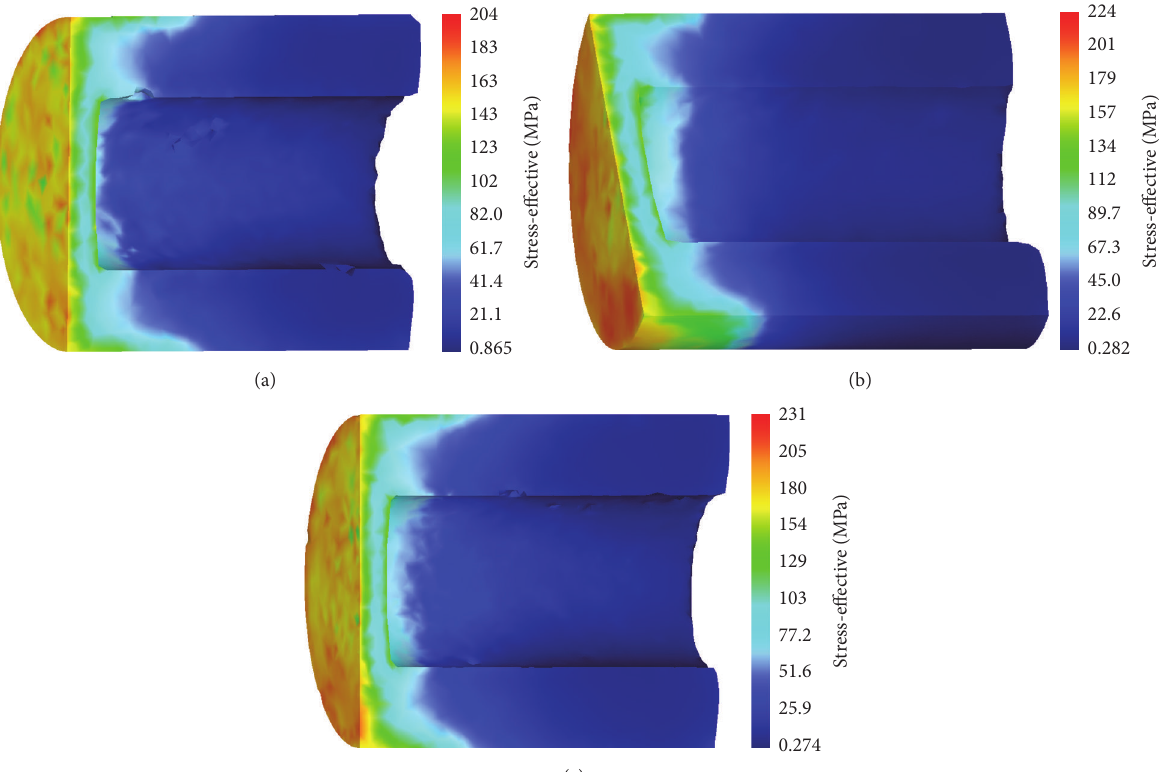
Figure 11: Stress field distribution of billet deformed at the piercing speed of (a) 50 mm/s, (b) 80 mm/s, and (c)